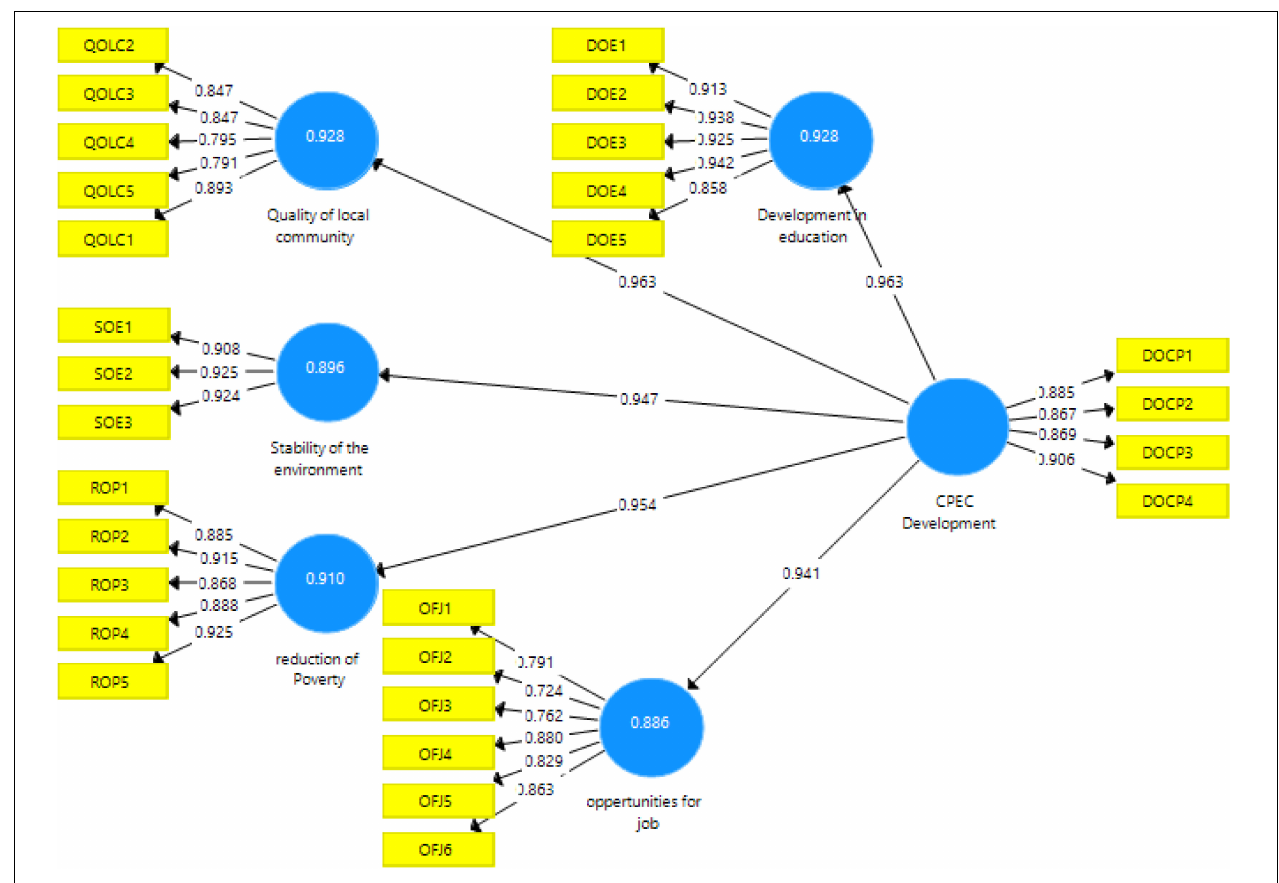
FIGURE 2 | Algorithm model.